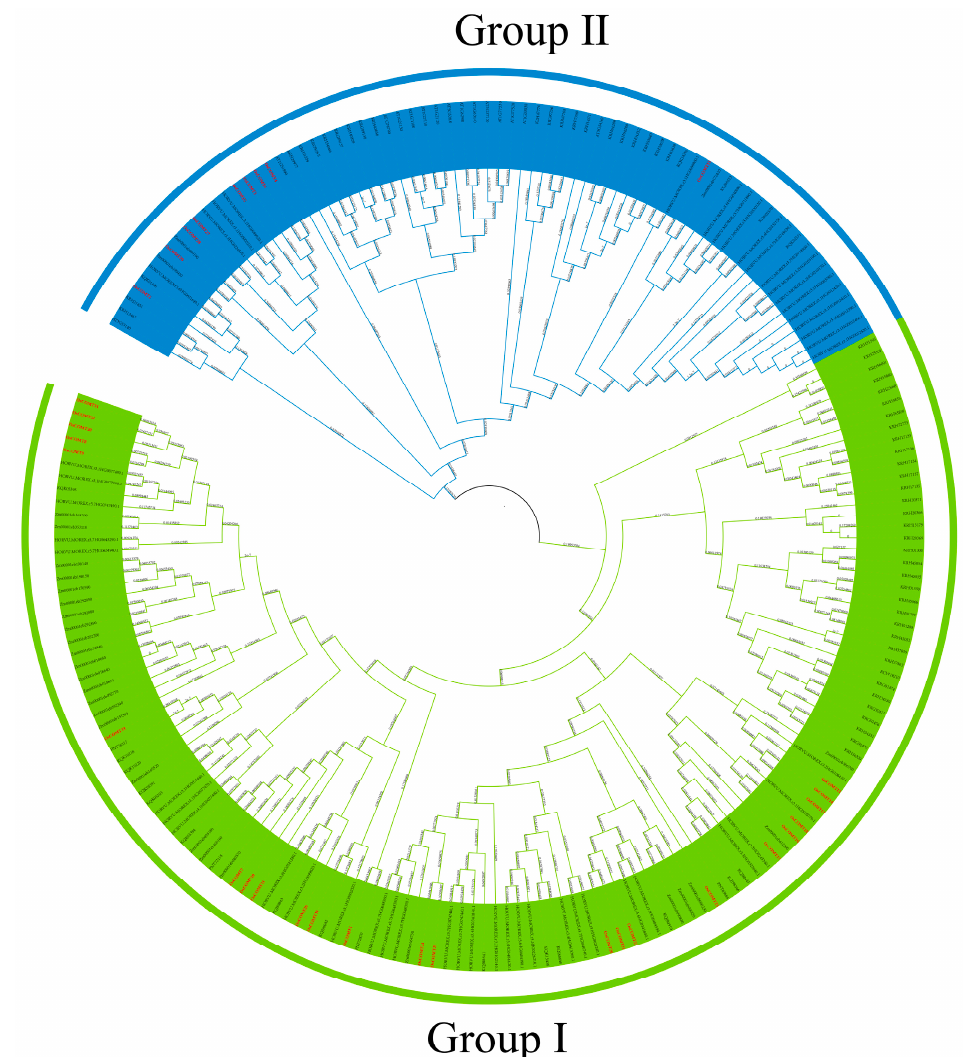
Figure 3. Phylogenetic relationships among 209 COMT proteins in Arabidopsis thaliana , Oryza sativa , Brachypodium distachyon , Zea mays , Glycine max , and Hordeum vulgare . The OsCOMTs are marked in red.